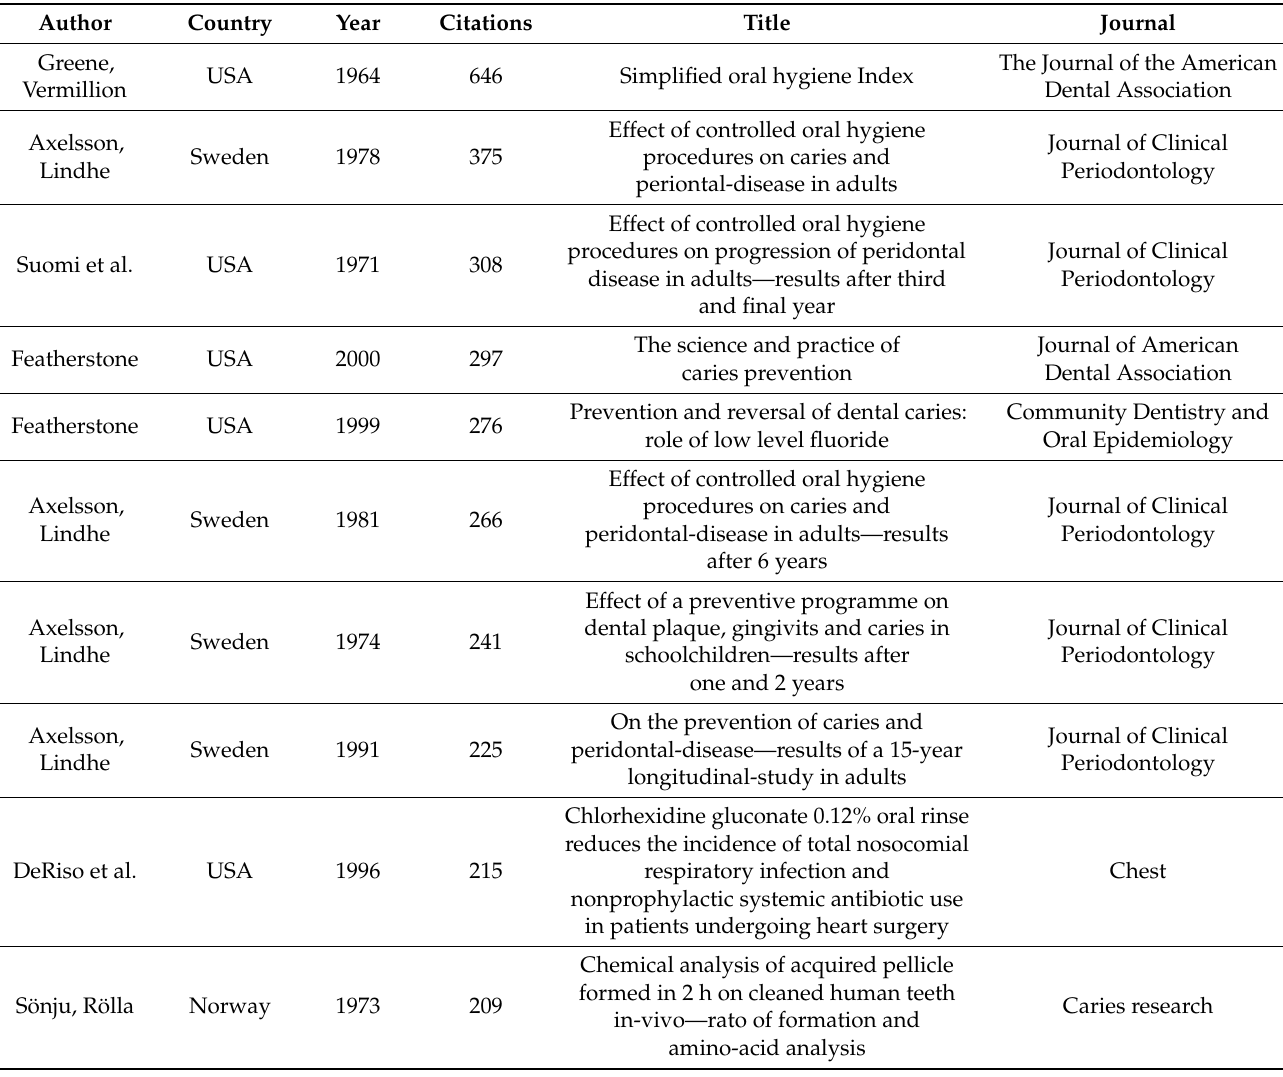
Table 1. Most cited